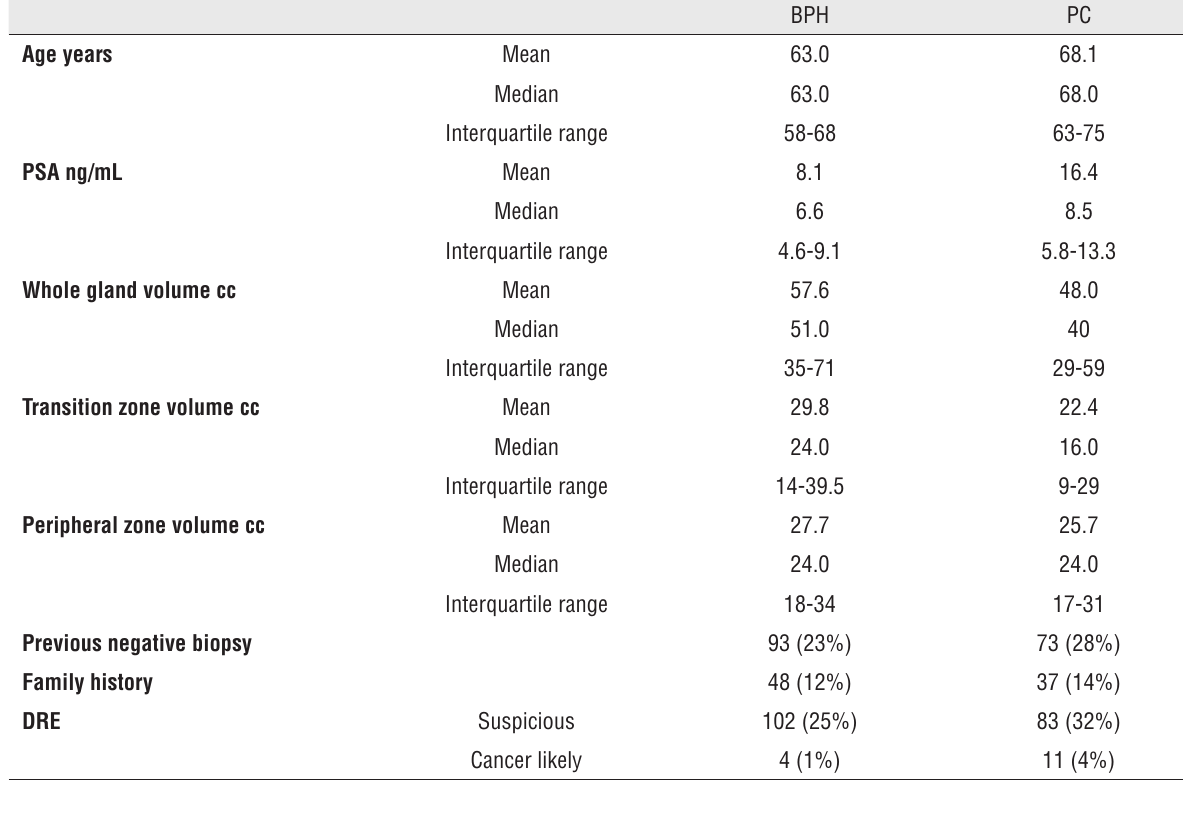
Table 1 - Patient